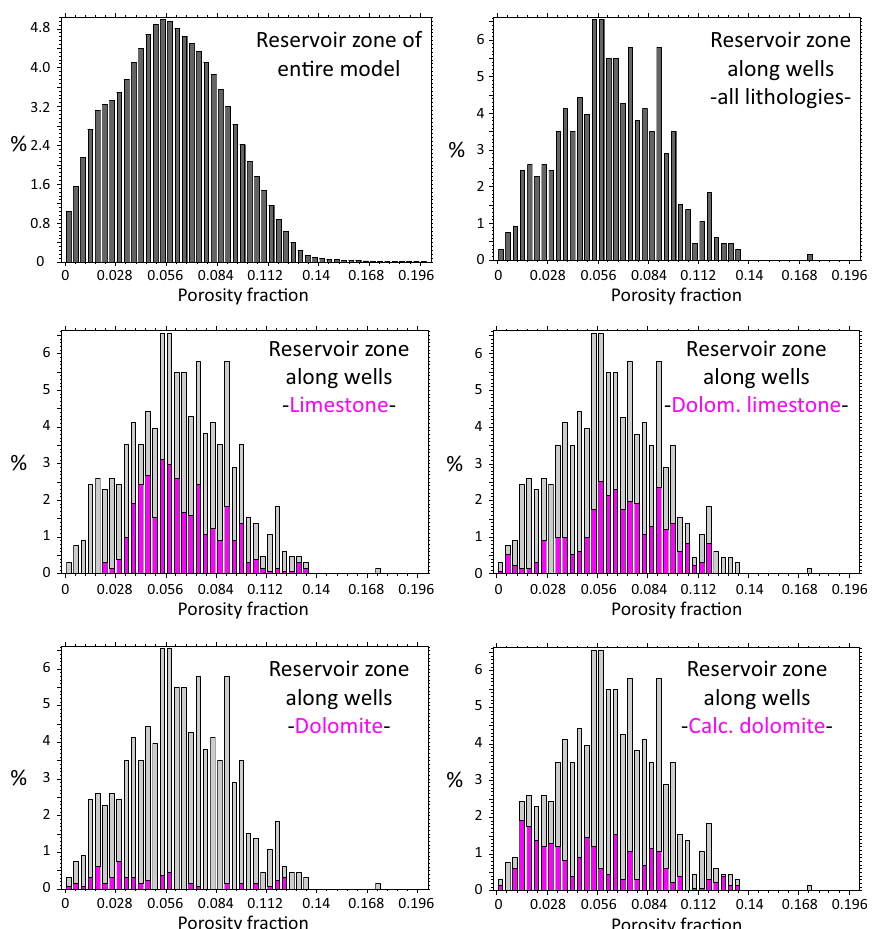
Fig. 13 Porosity histograms of the reservoir zone for the entire model and along the drilling paths derived from the inversion results. The wide range of porosity values results from the strong heterogeneity of the carbonates due to effect of different processes on the pore space, such as dolomitization, cementation and dissolution. Overall, the dolomitic limestone shows the highest porosities and the calcareous dolomite the